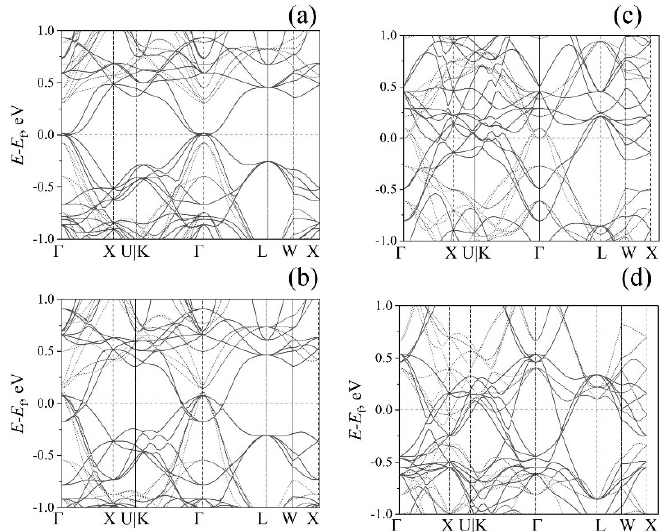
Figure 7. Spin-resolved band structures of ordered ( a ) Mn 2 CoAl, ( b ) Mn 2 CoGa, ( c ) Mn 2 VAl, ( d ) Mn 2 VGa Heusler alloys for the case of the XA structure (solid lines represent spin-up states; dotted lines correspond to spin-down states).